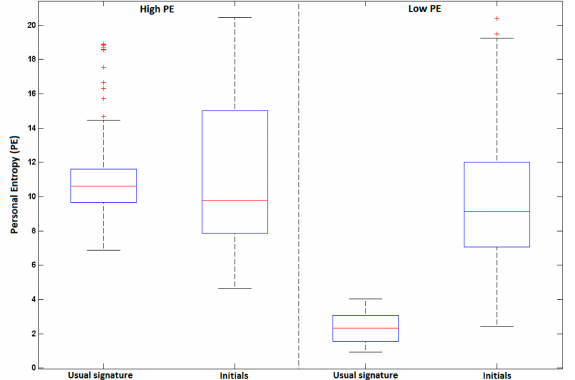
Figure 14. Boxplots of PE for users with highest (left) and lowest (right) PE values, considering their usual signature and